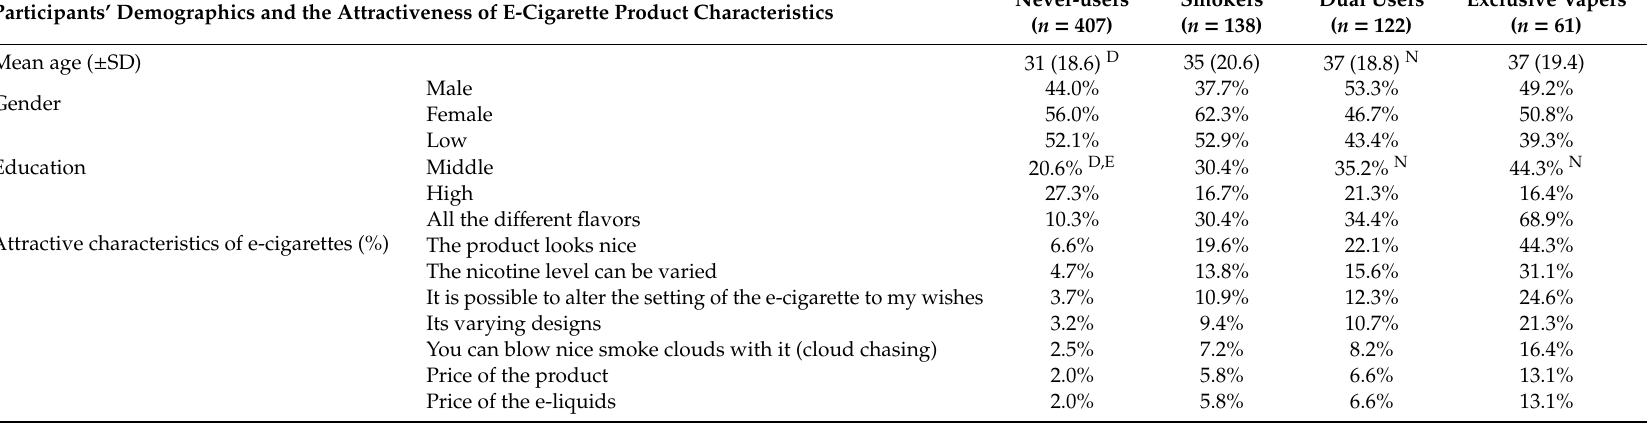
Participants’ Demographics and the Attractiveness of E-Cigarette Product